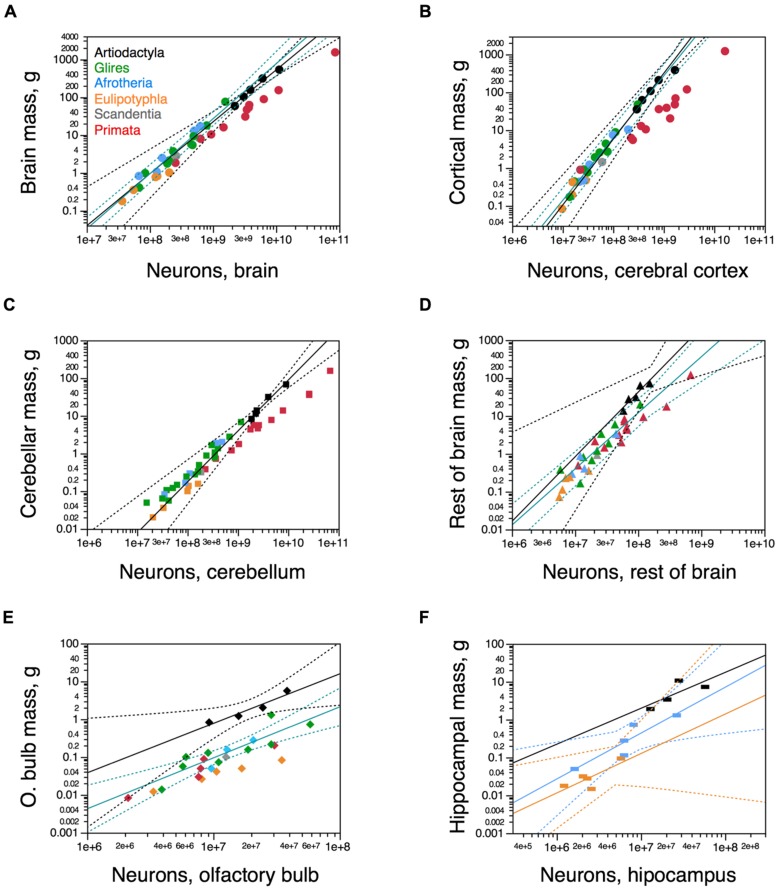
Neuronal scaling rules for artiodactyl brains and brain structures. Average brain structure mass for each species is plotted as a function of its total number of neurons. (A) Whole brain (excluding olfactory bulb); (B) Cerebral cortex (including hippocampus); (C) cerebellum; (D) rest of brain; (E) olfactory bulb; (F) hippocampus. (A) Artiodactyls overlap with the power function relating brain mass and number of brain neurons for glires and afrotherians together (green line; exponent, 1.456 ± 0.092), and the power function that applies to artiodactyls (black line, with the giraffe; exponent, 1.373 ± 0.120) also includes glires and afrotherians. (B) Artiodactyls overlap with the power function relating the mass of the cerebral cortex (including the hippocampus) and number of cortical neurons for glires and afrotherians together (green line; exponent, 1.645 ± 0.090), and the power function that applies to artiodactyls (black line, excluding the giraffe; exponent, 1.739 ± 0.092) also includes glires, afrotherians, and eulipotyphlans, but excludes primates. (C) The power function relating cerebellar mass and number of cerebellar neurons for artiodactyls (black line; exponent, 1.351 ± 0.118) includes other non-primate mammalian clades. (D) The power function relating mass and number of neurons in the rest of brain mass (brainstem to basal ganglia) for glires and afrotherians (green line; exponent, 1.481 ± 0.180) excludes four of five artiodactyl species. While all but one non-artiodactyl species fall below the power function that applies to artiodactyls (black line; exponent, 1.706 ± 0.376), the 95% CI is wide enough that they are still included. (E) The power function relating mass and number of neurons in the olfactory bulb for artiodactyls (black line; exponent, 1.309 ± 0.257) excludes all other mammalian clades. (F) The artiodactyl hippocampus falls within the 95% CI of the power functions relating hippocampal mass and number of neurons for afrotherians (blue line; exponent, 1.211 ± 0.312, p = 0.0304) and for eulipotyphlans (yellow line; exponent, 1.041 ± 0.422; p = 0.0903). Artiodactyl species in black, primates in red, glires in green, afrotherians in blue, insectivores in orange, scandentia in gray. Data from Herculano-Houzel et al. (2006, 2007, 2011), Azevedo et al. (2009), Sarko et al. (2009), Gabi et al. (2010), and Neves et al. (2014).